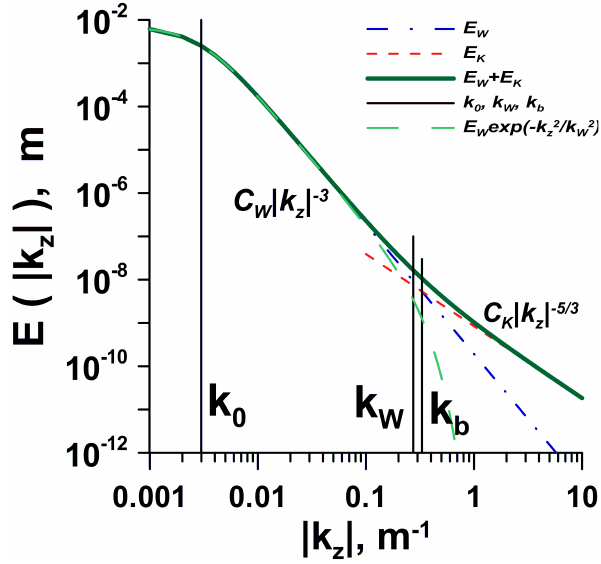
Fig. 1. One-dimension anisotropic (Eq. 4) and isotropic (Eq. 6) components of temperature perturbation spectrum (Eq. 1) for av- erage parameters at altitudes of 30–45km given in Table